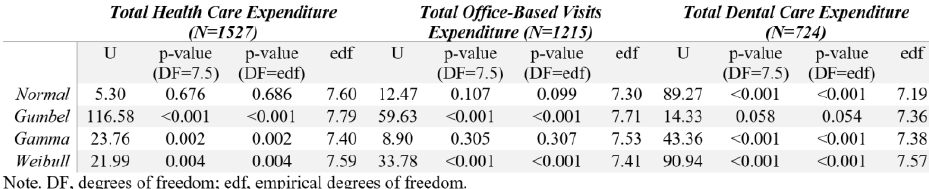
Table 5. Empirical Example: Goodness-of-Fit Tests on Conditional Probability Models for Log-Transformed Health Expenditures from